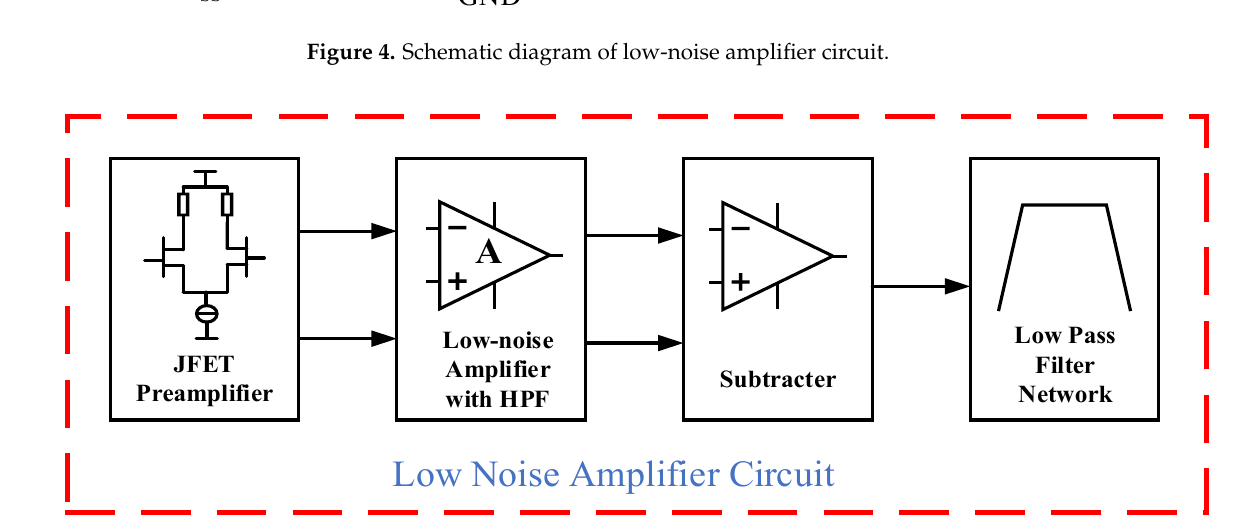
Figure 5. Schematic diagram of the function of the low-noise amplifier circuit.